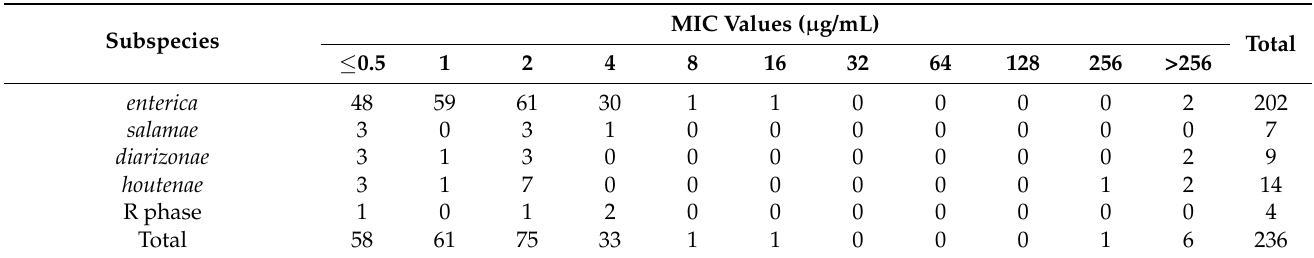
Table 4. Distribution of the tested Salmonella strains in relation to minimum inhibitory concentration (MIC) values and subspecies.